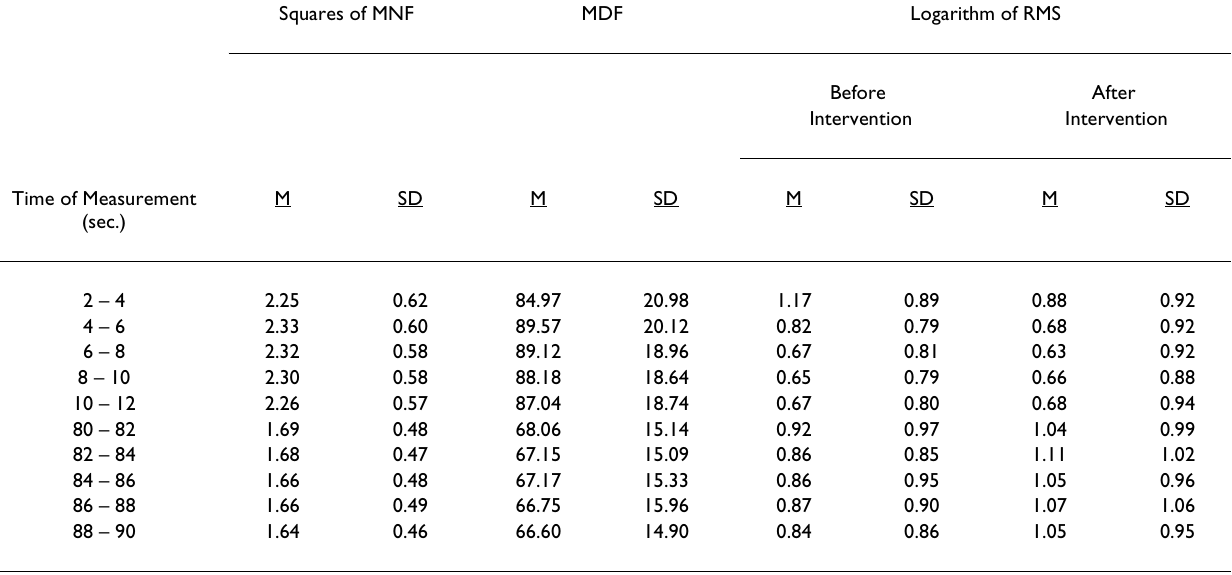
Table 3: Summary of Changes in EMG – Measurements (N = 29) Squares of MNF MDF Logarithm of RMS